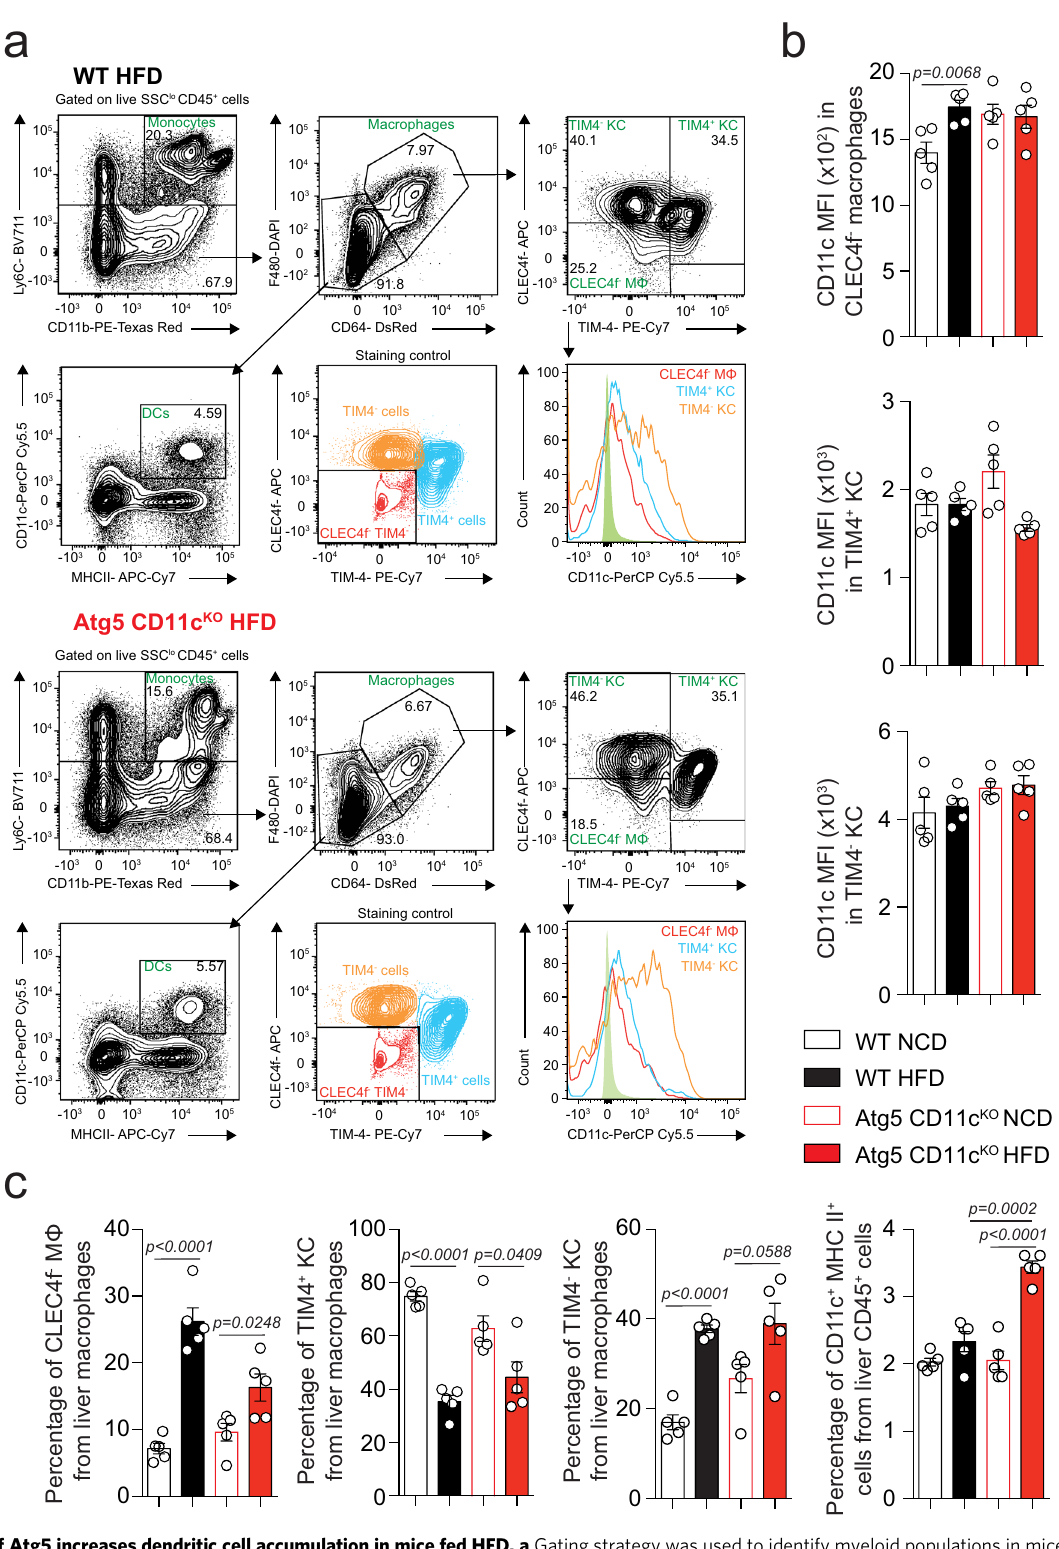
Fig. 3 Loss of Atg5 increases dendritic cell accumulation in mice fed HFD. a Gating strategy was used to identify myeloid populations in mice fed NCD or HFD for 14 weeks (top panel WT cells, bottom panel Atg5 CD11c KO mice). The level of isotype-matched stain de fi nes TIM4 − CLEC4f − population and discriminates TIM4 + and TIM4 − cells. b Histogram of CD11c expression in macrophage subpopulations (CLEC4f − macrophages, TIM4 + KC and TIM4 − KC) from WT and Atg5 CD11c KO mice. c Percentage of CLEC4f - macrophages, TIM4 + KC and TIM4 − KC from total liver macrophages in WT and Atg5 CD11c KO mice (NCD vs. HFD). Error bars are the mean ± SD, ns nonsigni fi cant, two-tailed Student ’ s t test, n = 5 mice. Experiments were performed three times. Source data are provided as a Source Data fi